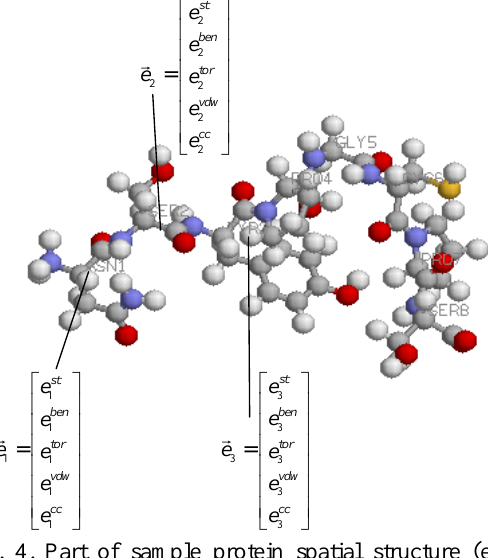
Fig. 4. Part of sample protein spatial structure (eight amino acids) with representative energy signatures for consecutive